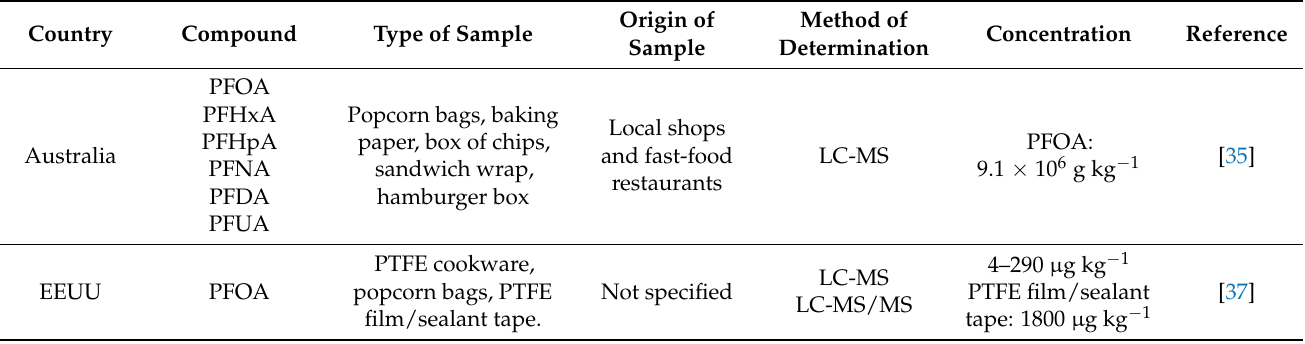
Table 1. Determination of PFAS content in